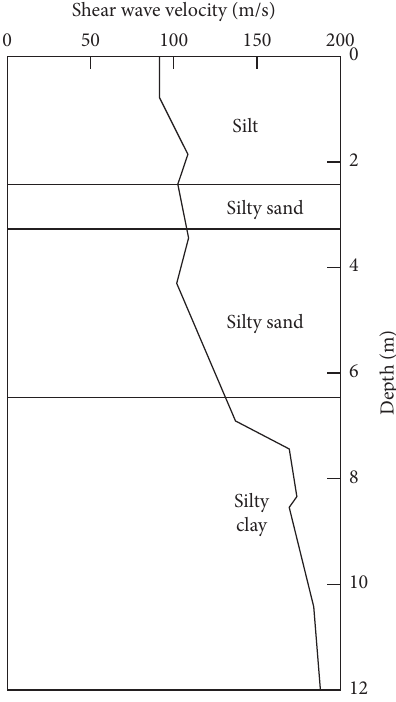
Figure 4: The one-dimensional model of Wildlife Site Array (after Ching